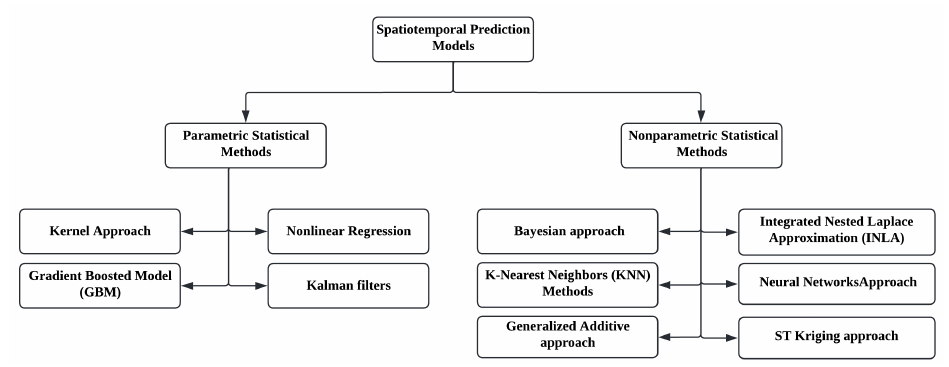
Figure 2. A schematic diagram of spatiotemporal